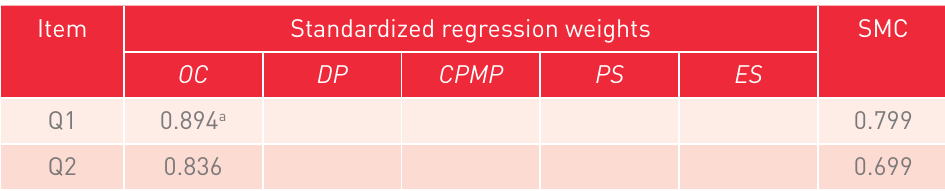
Standardized regression weights and SMCs Item